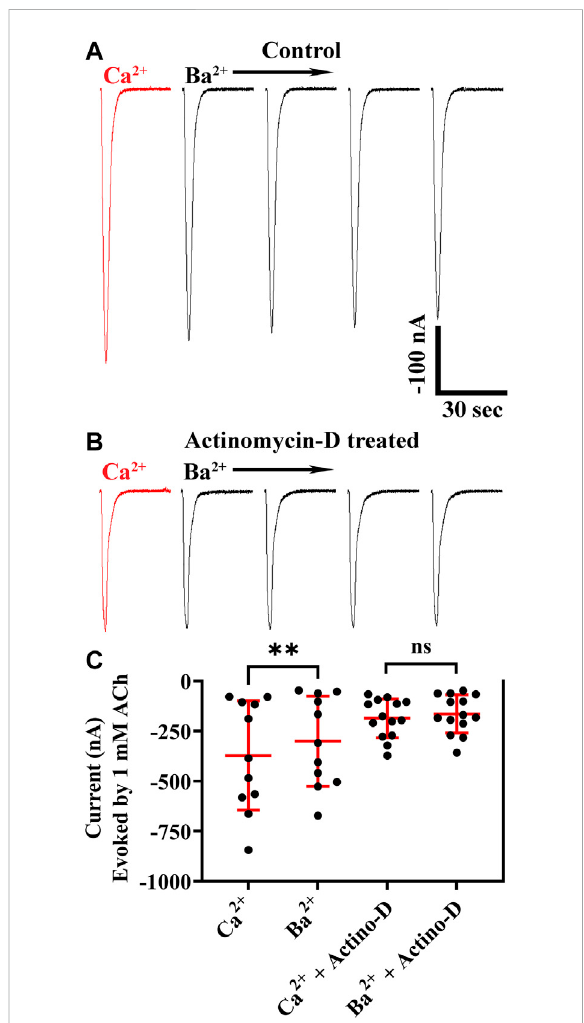
FIGURE 2 Human α 10nAChRcurrentsaresmallerinthepresenceofBa 2+ compared to those in Ca 2+ . Oocytes were injected with cRNA encoding human α 10 subunits and treated for 36 h with frog saline containing STR (20 μ M) and assessed by voltage-clamp electrophysiology for functional responses to acetylcholine (ACh; 1 mM)in thepresenceofcalciumorbarium. (A) Current traces from an oocyte perfused with saline containing calcium (1.8 mM) then with salinewhere calciumwasreplacedwith equimolar barium. The responses in the presence of barium were smaller than those recorded in the presence of calcium ( − 373 ± 273 nA vs. − 301 ± 225 nA, respectively; n = 11). The experiment was repeated with sibling oocytes that had been incubated with 1 µM actinomycin-D (Actino-D) to inhibit RNA transcription. (B) Current traces from an oocyte treated with Actino-D and perfused with saline containing calcium (1.8 mM) then with saline where calcium was replaced with equimolar barium. (C) No differences in response amplitudes in the presence of calcium compared those recorded in the presence of barium ( − 186 ± 96 nA vs. − 164 ± 96 nA, respectively; n = 14) were foundinoocytestreatedwithActino-D.Thecurrenttracesin (A) and (B) areshownwiththe30 stheinterpulseintervalsreducedto5 sfor brevity and the scale bar in (A) also applies to (B) . The “ ± ” and error bars indicate SD. The “ n ” indicates the number of oocytes obtained from two